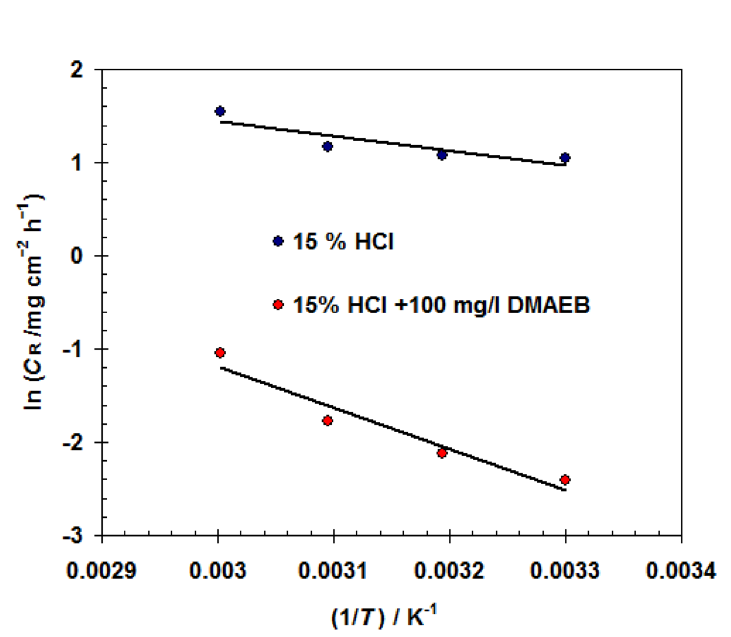
Figure 6. Arrhenius plot for N80 C-steel pipe in 15.0% HCl solution without and with 100 mg/l